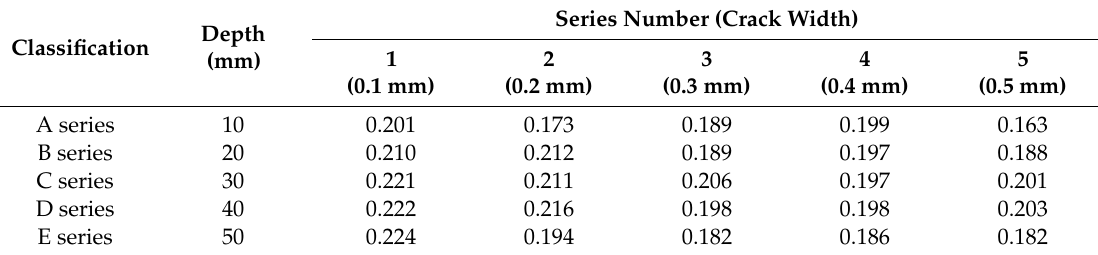
Table 2. Calculated oxygen diffusion coefficient from acrylic specimens.